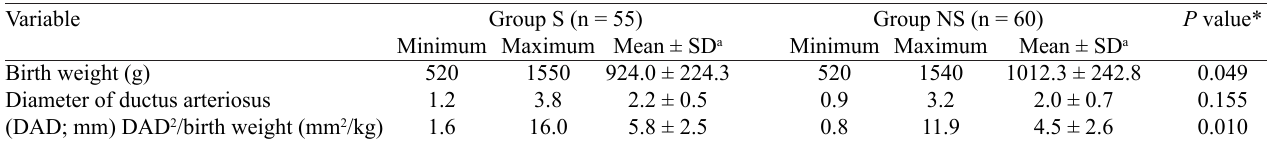
Table 1. Main characteristics of the preterm neonates diagnosed with patent ductus arteriosus submitted to surgical (group S) or non-surgical (group NS) treatment of the